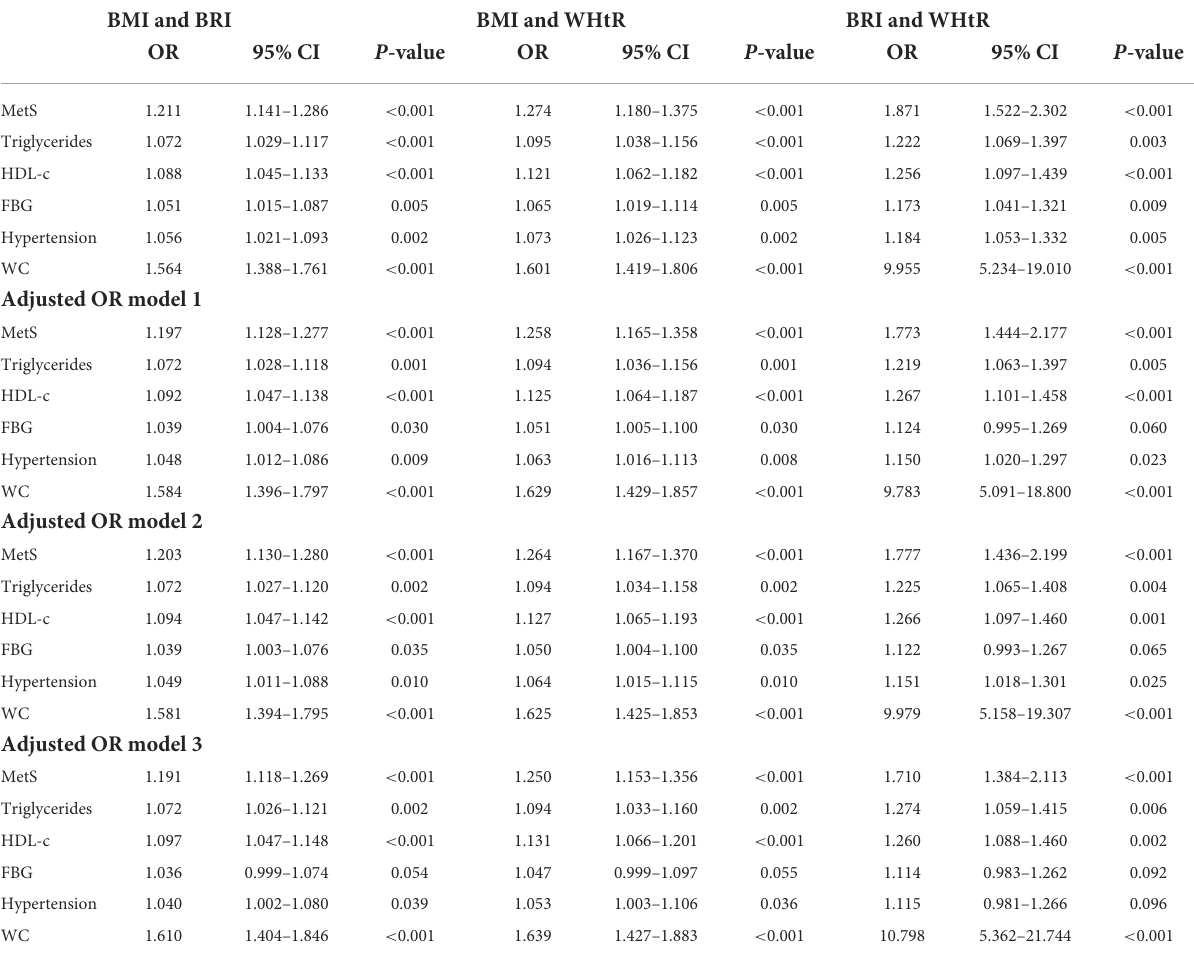
Three logistic regression models were applied: model 1, adjusted for age; model 2, adjusted for age, race, marital status, driving experience in years, and education; and model 3, further adjusted for age, race, marital status, driving experience in years, education, smoking, alcohol and physical activity. BMI, Body Mass index; WC, Waist circumference;